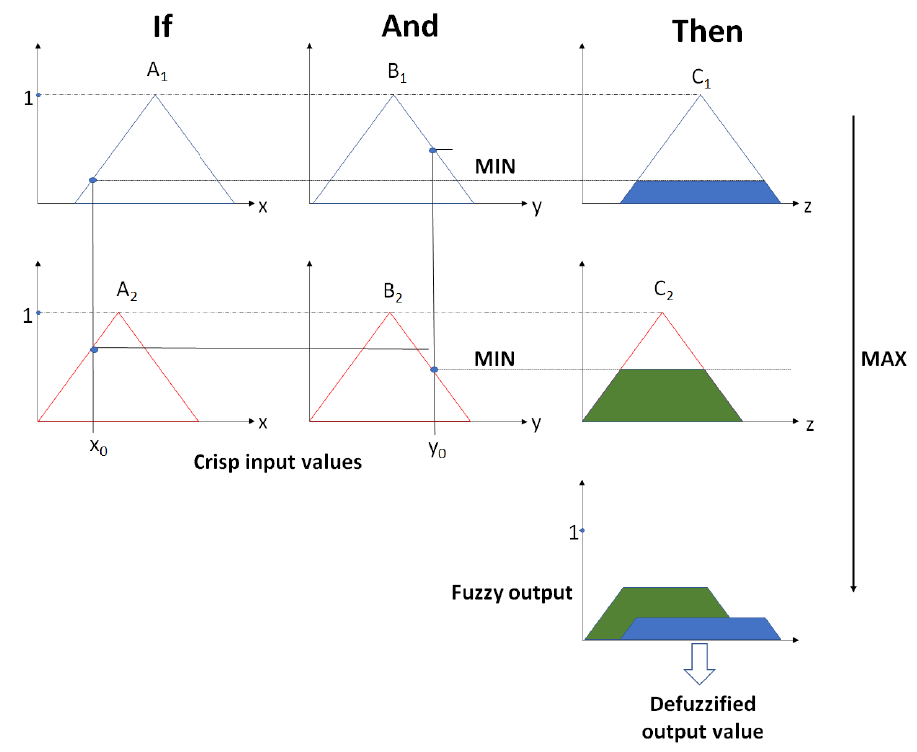
Figure 6. Mamdani FIS using MIN and MAX operators.